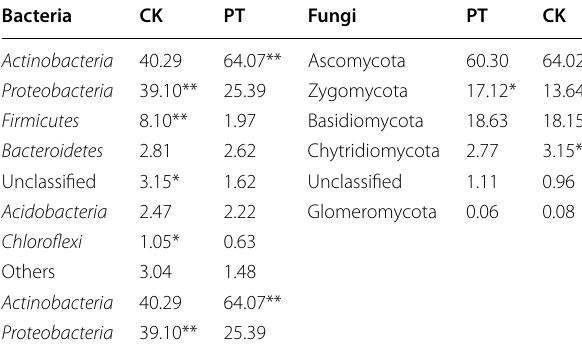
Table 1 The differences for microbial community compositions of tobacco rhizosphere between the CK and PT treatments at the phylum level.CK and PT represent the control treatment and tobacco residue treatment, respectively, similarly hereinafter